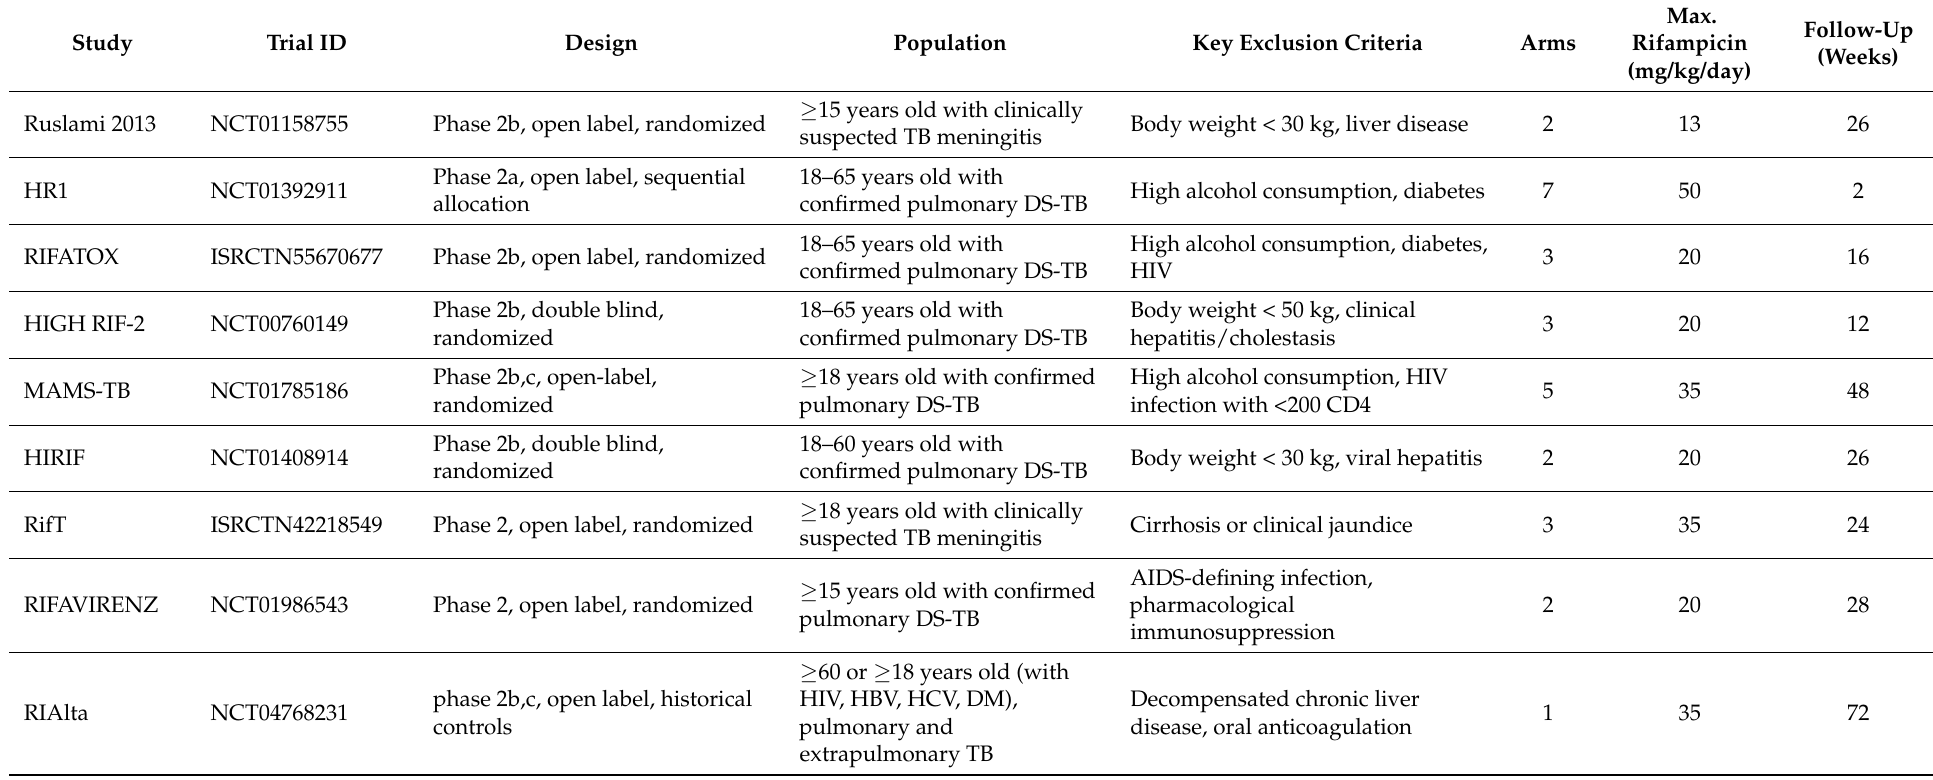
Table 1. Comparison of recent phase 2 trials using high-dose rifampicin for